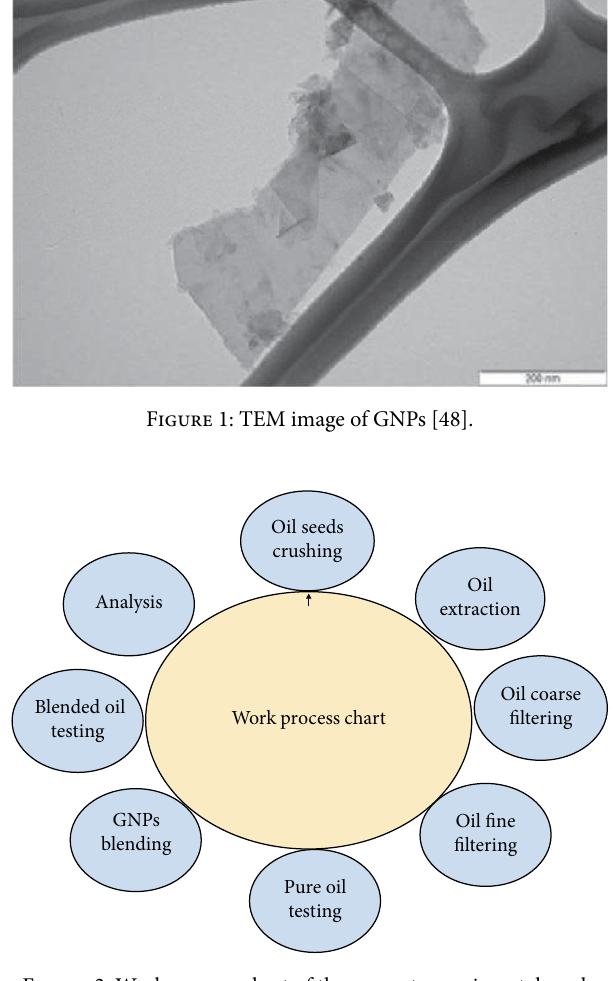
Figure 2: Work process chart of the current experimental